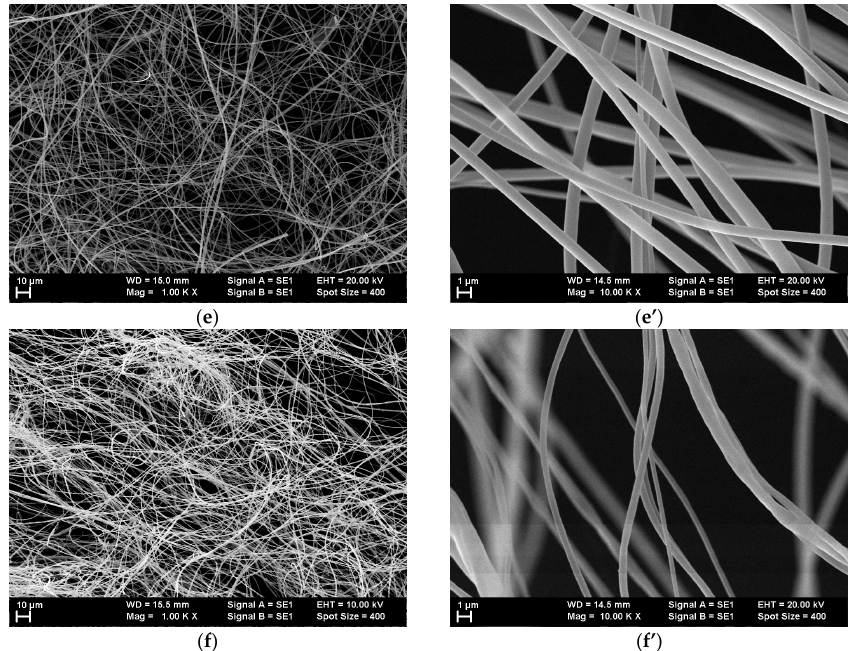
Figure 3. Scanning electron microscopy (SEM) images at two different magnifications (1000× and 10,000×) of the electrospun polymer fibers doped with ( a , a’ ) coumarin 7, ( b , b’ ) coumarin 6, ( c , c’ ) fluorescein, ( d , d’ ) rhodamine 6G, ( e , e’ ) sulforhodamine B, and ( f , f’ ) sulforhodamine 101. The fibers’ diameters ranged between 300 nm and 1 µm.